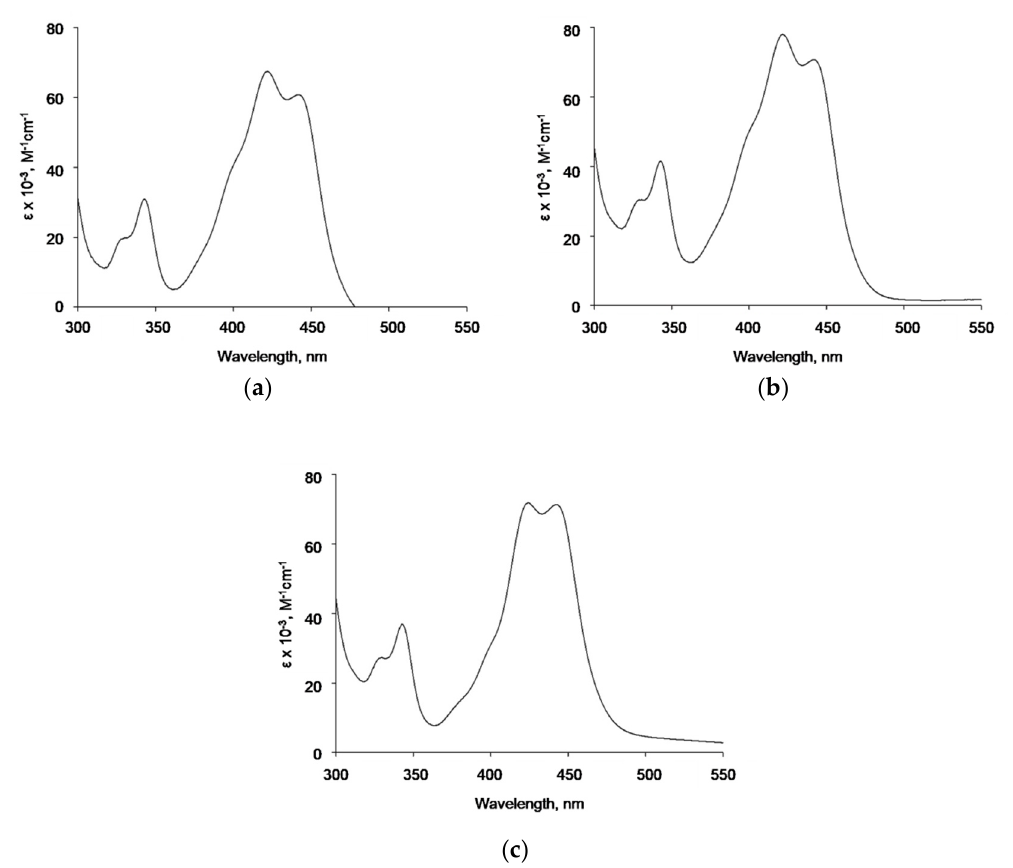
Figure 4. UV / vis spectrum of AgNPs titrated with ICR-191 reduced by AgNPs’ absorbance. ( a ) Spectrum of naked AgNPs (initial concentration 64.63 µ g / mL) titrated with ICR-191 (concentration range 25.19–97.92 µ M); ( b ) spectrum of AgNP-TBA (initial concentration 19.67 µ g / mL) titrated with ICR-191 (concentration range 25.01–97.23 µ M); ( c ) spectrum of AgNP-MUA (initial concentration 6.45 µ g / mL) titrated with ICR-191 (concentration range 23.28–90.68 µ M).